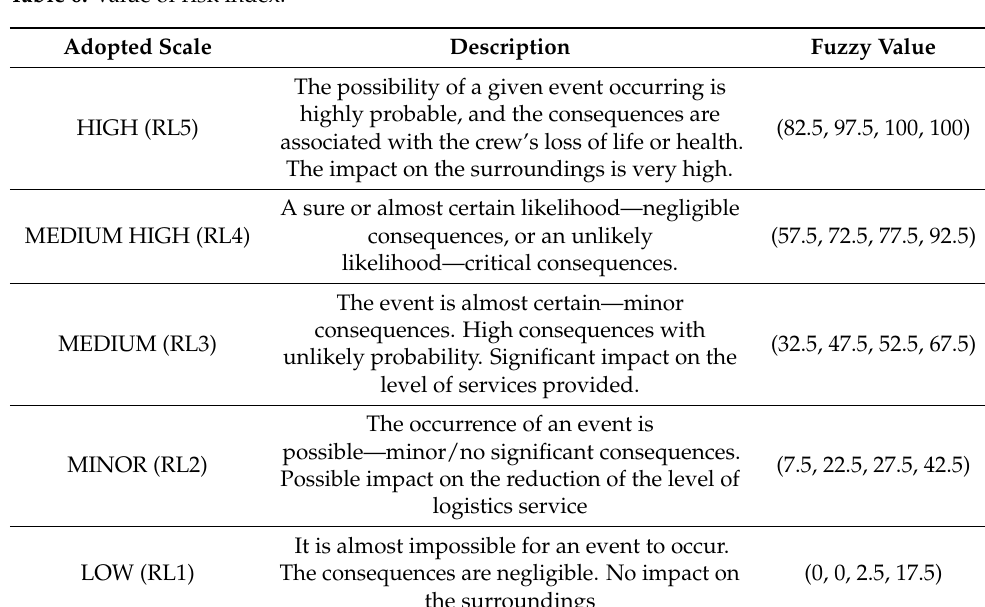
Figure 7. The shape of membership functions: ( a ) probability of the scenario occurrence; ( b ) conse- quences of the scenario occurrence; ( c ) risk level. Table 6. Value of risk